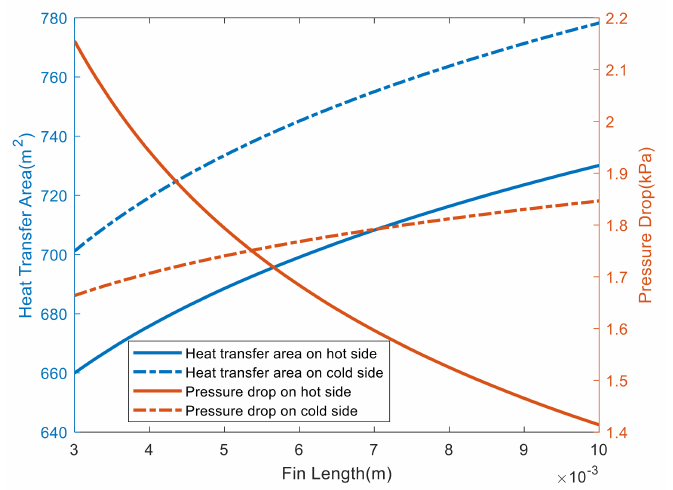
Figure 7. Effect of fin length on heat transfer area and pressure drop of